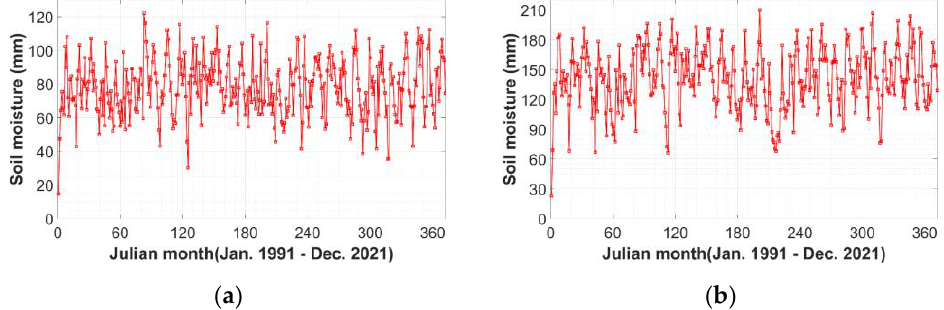
Figure 4. Monthly inflow simulation results: ( a ) Andong Dam Basin; ( b ) Hapcheon Dam Basin.